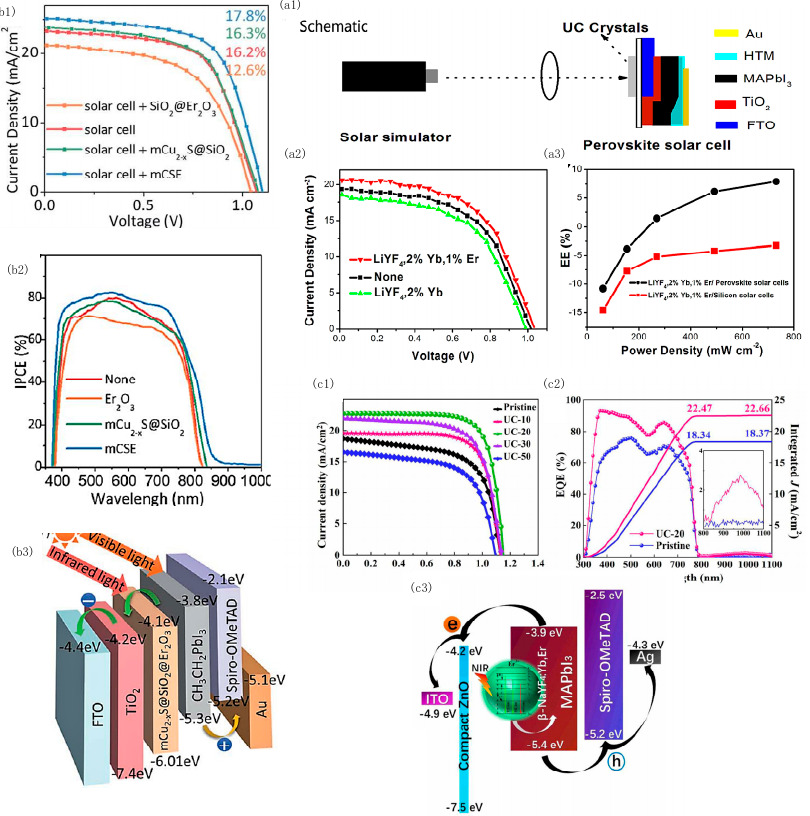
Figure 3. ( a1 ) Schematic of the J – V characteristic curves measurement of the perovskite solar cells under the simulated sunlight excitation; ( a2 ) J – V curves of the perovskite solar cells: LiYF 4 :2% Yb 3+ , 1% Er 3+ crystals, LiYF 4 :2% Yb 3+ crystals, and no crystal measured under simulated solar illumination with an intensity of 0.73 W · cm − 2 ; ( a3 ) Enhancement efficiencies (EE) of the perovskite solar cells and silicon solar cells with LiYF 4 :2% Yb 3+ , 1% Er 3+ crystals dependent on the excitation power density.